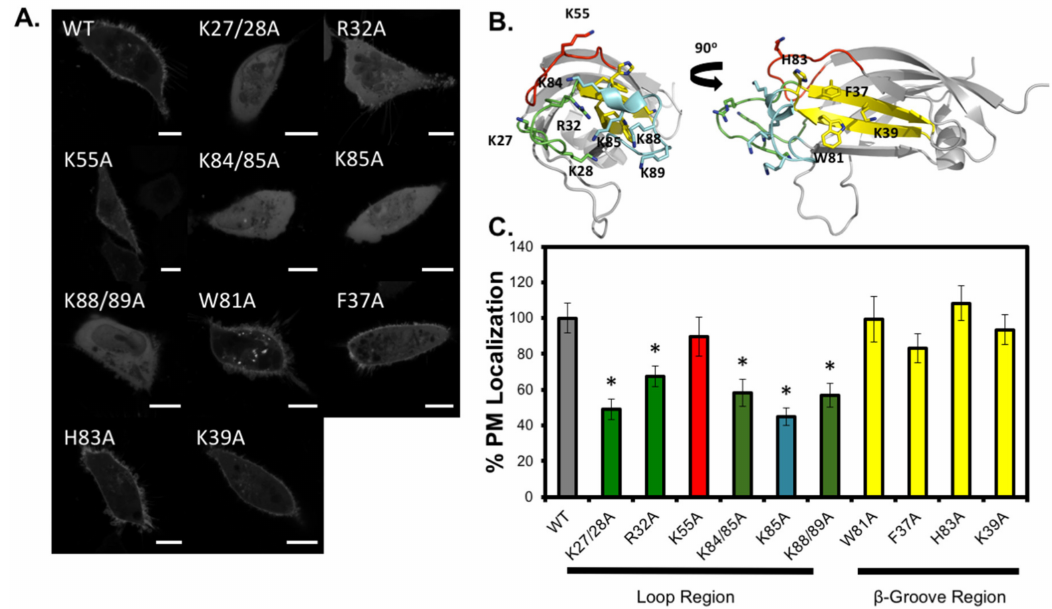
Figure 8. The C2 domain loop region, not the β -groove, is essential for Smurf1 plasma membrane localization. ( A ) Representative images of mCherry–Smurf1 fusion constructs (wild-type and mutants in the C2 domain of the full-length construct). A549 cells were transfected with the indicated mutant Smurf1 full length constructs and imaged on a confocal microscope 24 h post-transfection. Between 17-23 cells were analyzed per mutant from three independent transfections. ( B ) The Smurf1 C2 domain crystal structures is depicted in cartoon form (PDB ID: 3PYC) to highlight mutated residues in the loop regions or the β -groove. ( C ) %PM localization was quantified with a MATLAB script. %PM localization = Ave PM fluorescence / (Ave PM fluorescence + Ave cytoplasm fluorescence) × 100%. Calculated values are normalized to WT. A one-way ANOVA was utilized to ascertain statistically significant changes in %PM localization with respect to WT. * p < 0.01. Error bars represent SEM. Scale bars = 10 µ